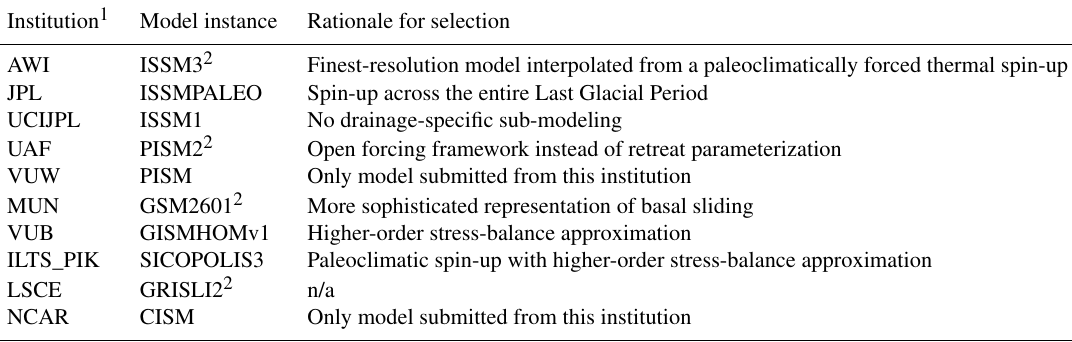
Table 2. ISMIP6 ensemble model instances considered for GBaTSv2.